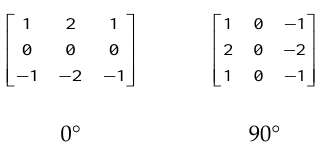
Figure 2. Sobel templates in two directions.